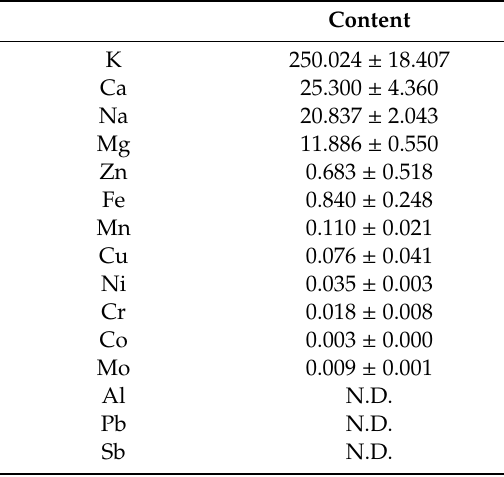
Table 4. Mineral contents of AFH (mg /